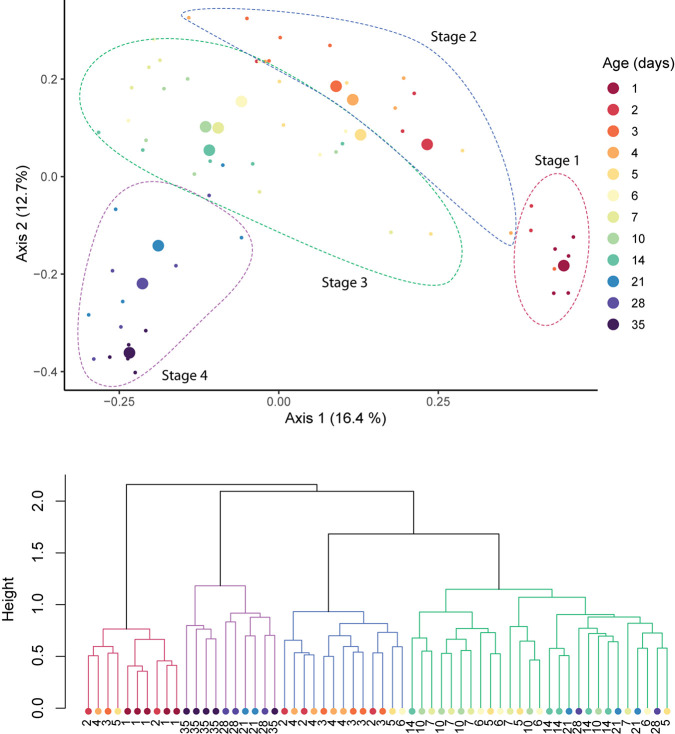
Sequential shifts in the community structure of the fecal microbiomes of pigs after birth. A PCoA plot of Bray–Curtis distances between samples (top). Large circles represent the centroid of all samples belonging to pigs of the same age, and small circles indicate individual samples. Clustering of samples was confirmed with adonis (p = 0.001) and clusters are outlined with dotted lines. Ward’s clustering of Bray–Curtis distances (bottom). Clusters are indicated by branch color.